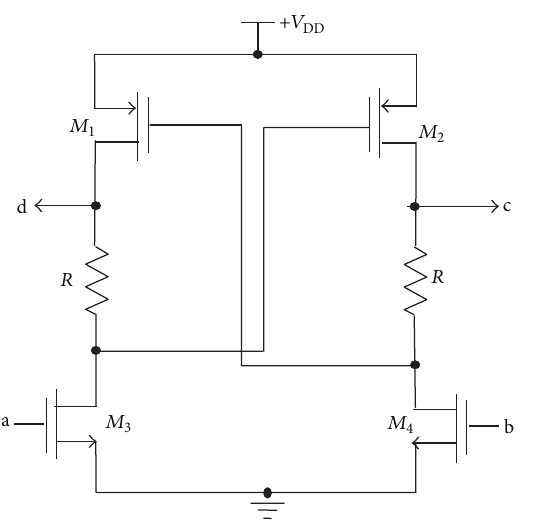
Figure 2: Proposed ULPD-DCVSL structure. Figure 2. ULPD is a combination of PMOS and